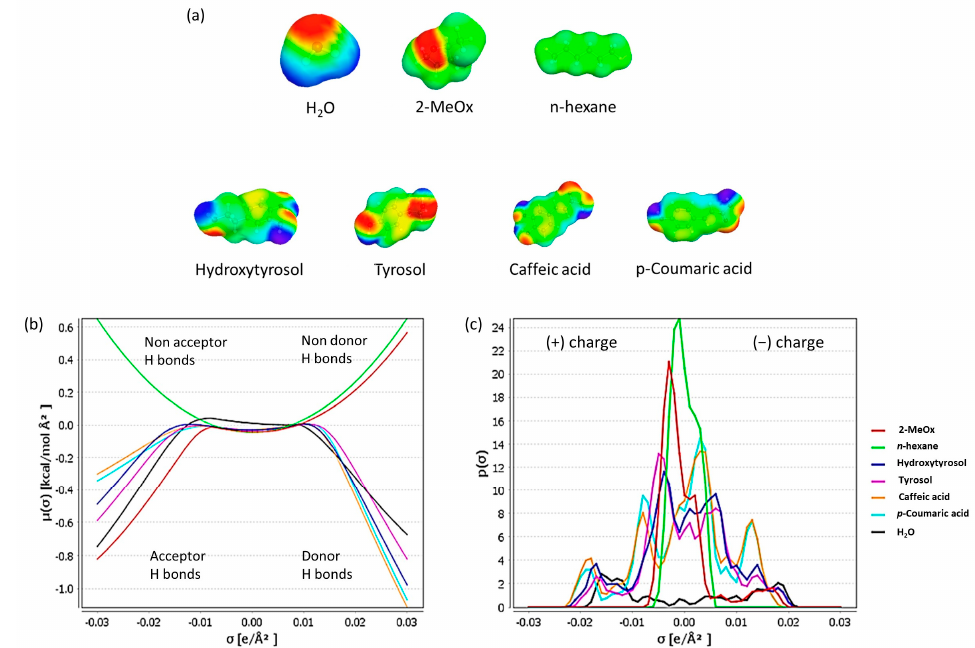
Figure 4. COSMO-RS theoretical solubility prediction: ( a ) solvents and solutes s-surface; ( b ) σ -Potential; ( c ) σ -Profile.